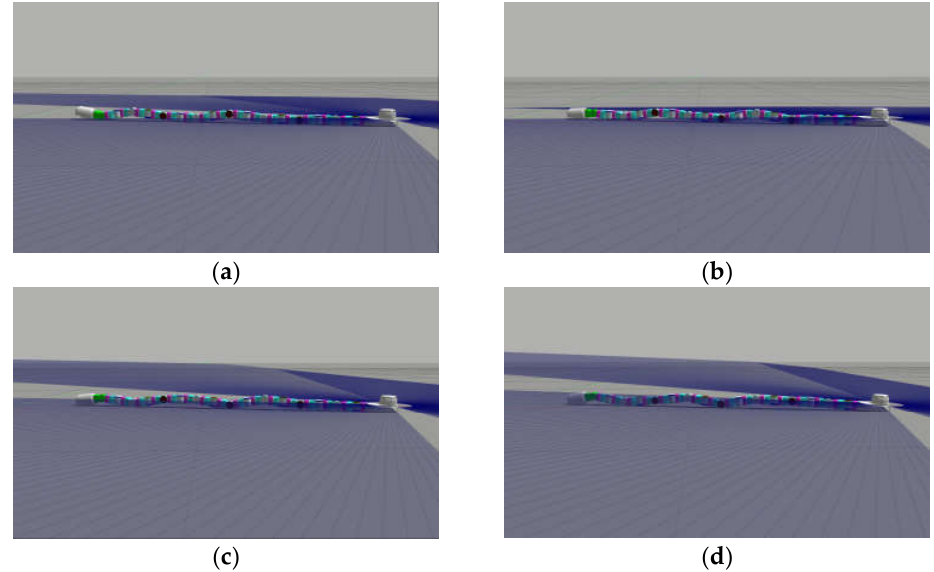
Figure 10. Head stabilization simulation with stabilization algorithm. ( a ) Phase is 0; ( b ) phase is π/2; ( c ) phase is π; ( d ) phase is 3 π/2.